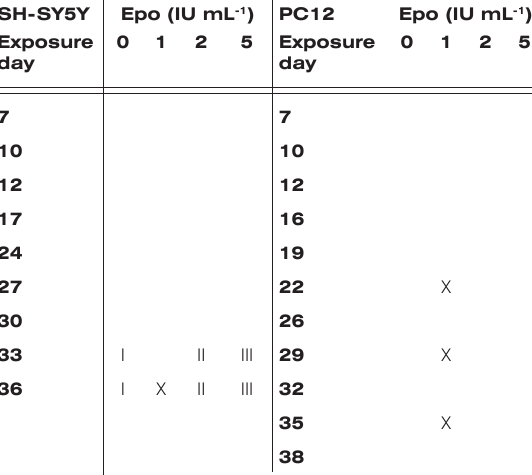
Table 1. List of SH-SY5Y and PC12 cell sample collections during chronic rHuEpo treatment.